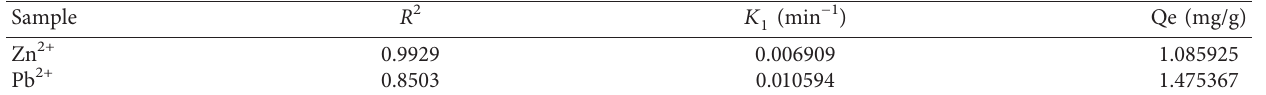
Table 3: A summary of the pseudo-first-order reaction kinetic model parameters.